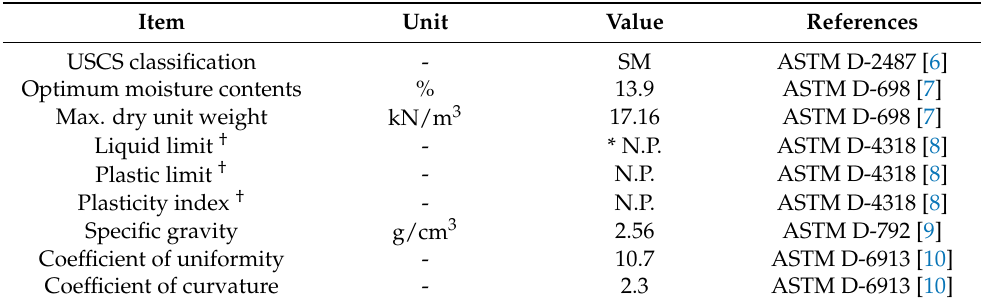
Table 1. Physical properties of multi-contaminated